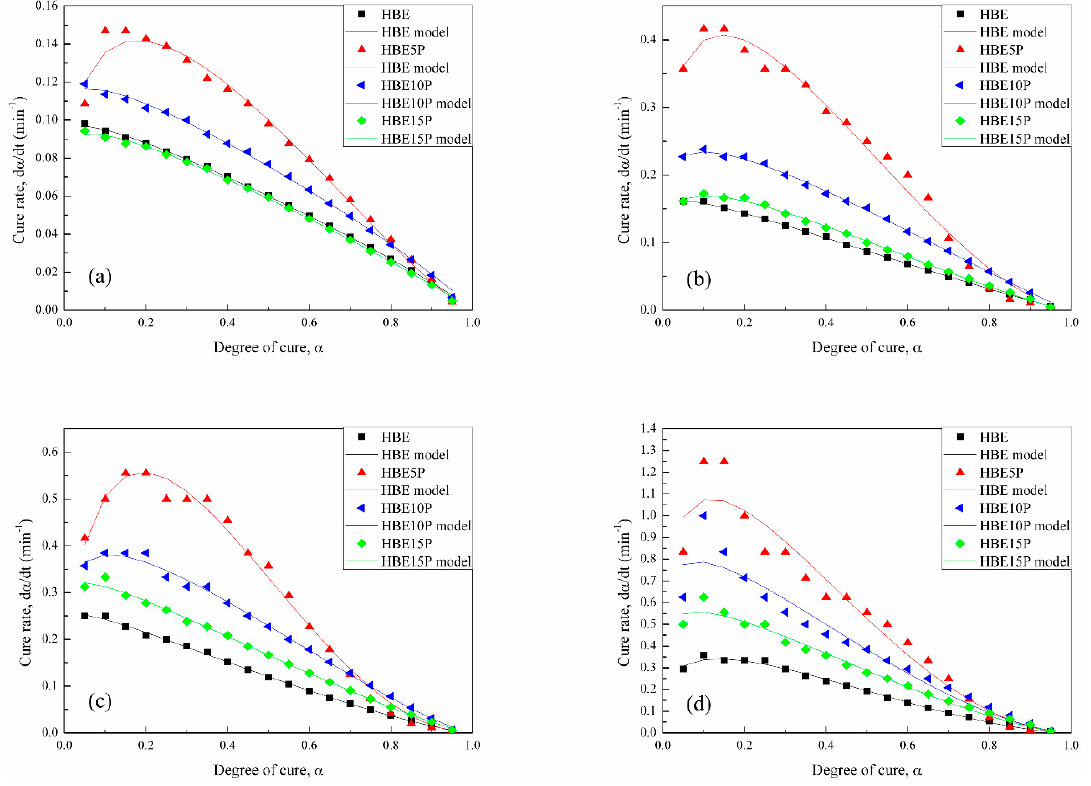
Figure 7. The cure rate and degree of cure of HBE with various PEG contents at ( a ) 70 °C, ( b ) 80 °C, ( c ) 90 °C, and ( d ) 100 °C. Symbol shows experimental result and solid line is model fitting.